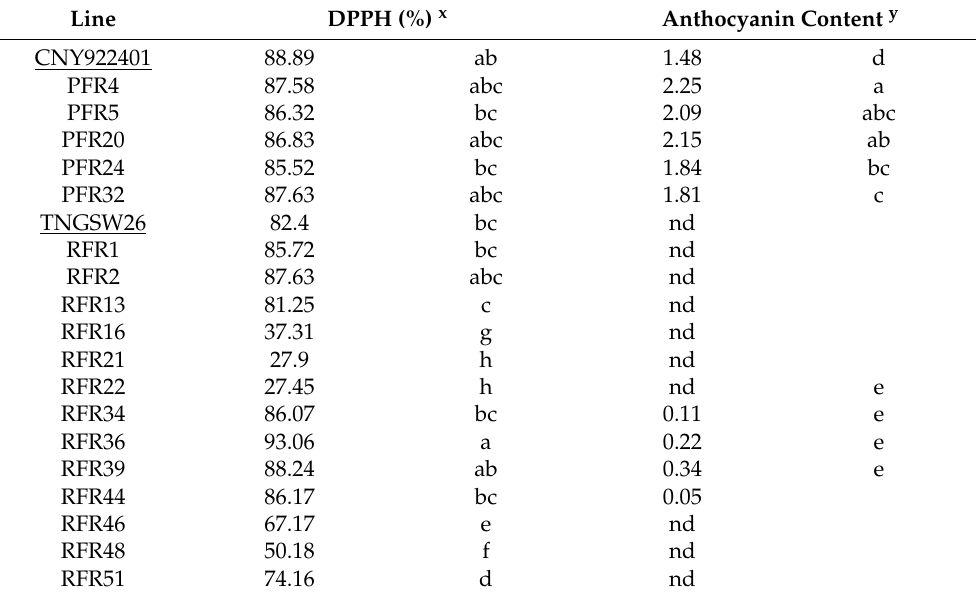
Table 2. DPPH scavenging activity, and anthocyanin content of the 20 lines, including recurrent parents, CNY922401, and TNGSW26 in 2017.